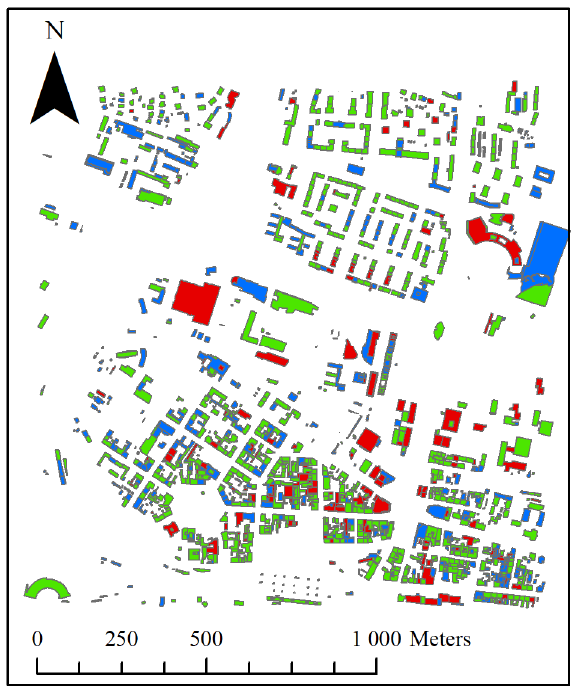
Figure 6. The presentation of the qualitative assessment results of the mesh models for individual buildings in Katowice test area: Class 1 - blue, Class 2 - green, Class 3 - red. (see Table